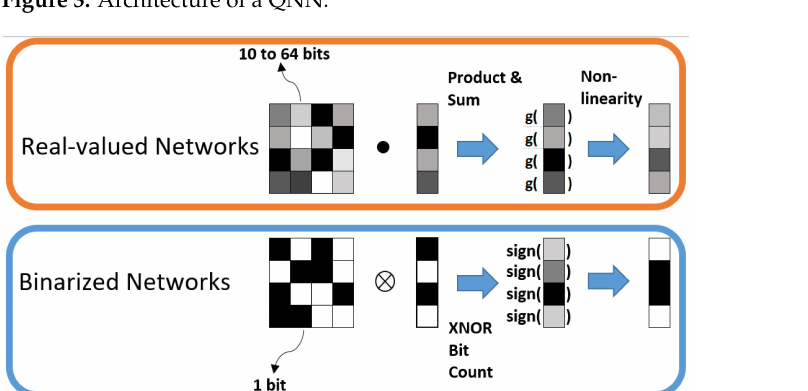
Figure 3. Architecture of a QNN.